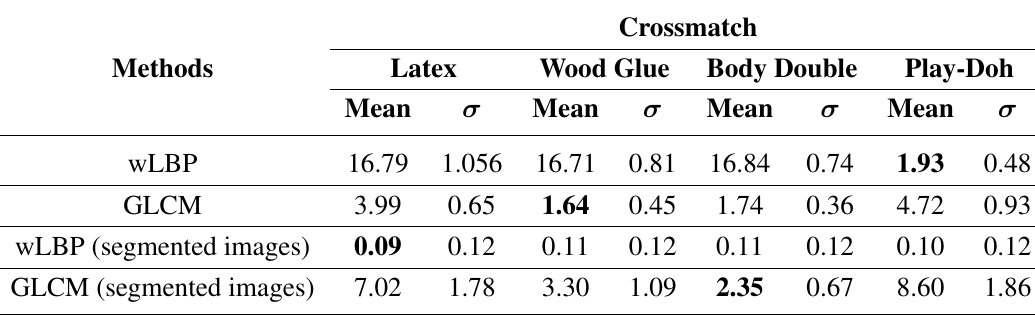
Table 3. ACER for each material of the Crossmatch dataset, study 1 (ACER in % ).